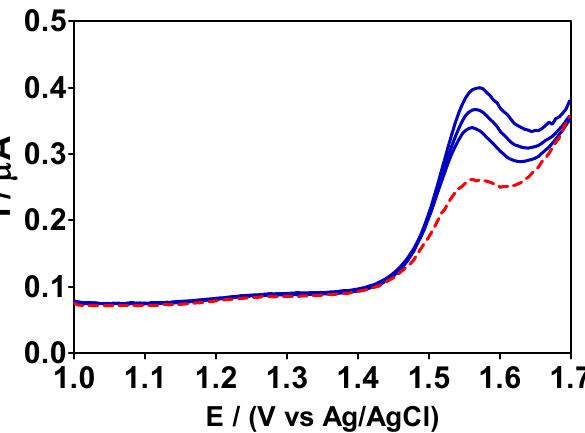
Figure 2. Results obtained for determining HCQ in river water by the standard additions method using the DPV approach with a cork-graphite sensor ( — ) standard additions of 1 mM HCQ in 0.1 M H 2 SO 4 (200, 400 and 600 µL) as well as ( --- ) river water sample.